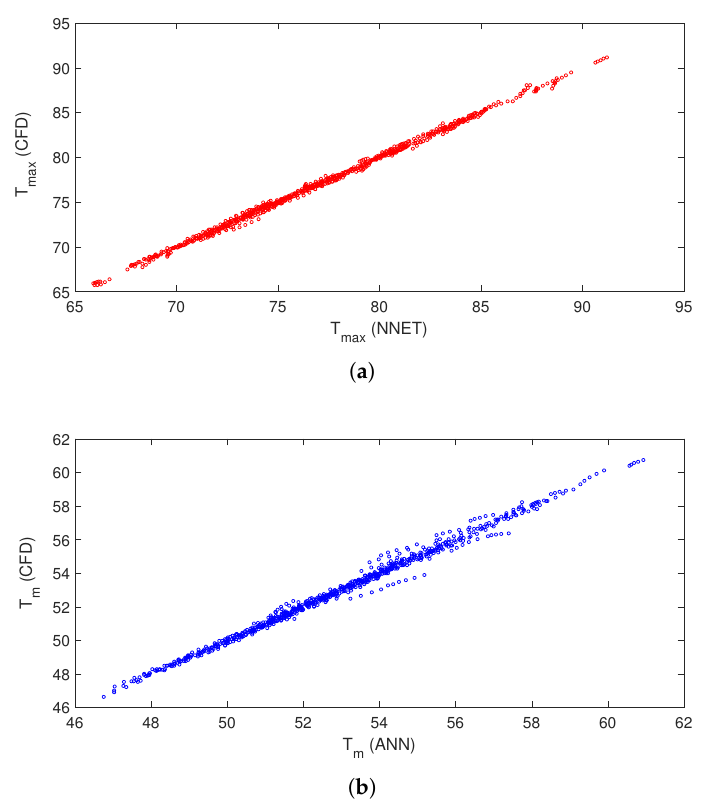
Figure 13. Estimation of maximum ( a ) and average ( b ) panel temperatures by using